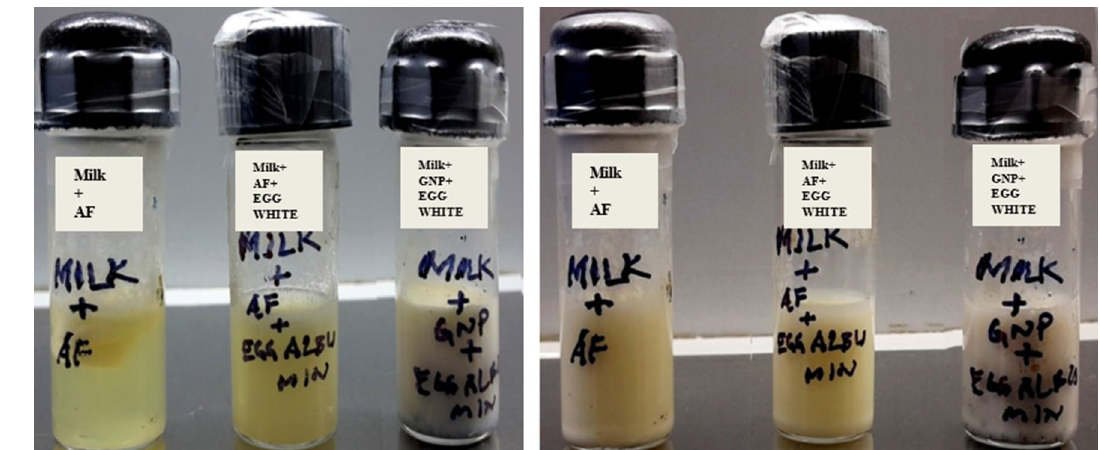
Figure 9. Papain inhibition test ( A , B ) with (milk + chicken egg white), (milk + chicken egg white + prismatic gold nanozymes), A = 0 h., B = 72 h